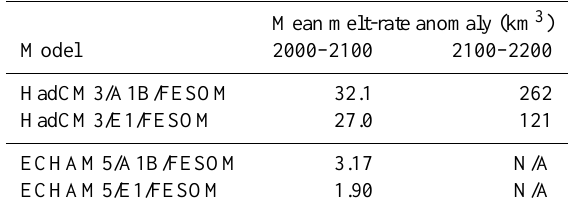
Table 2. The 21st and 22nd century melt-rate anomalies with re- spect to the 1980–1990 mean, integrated over the floating portion of the present-day drainage